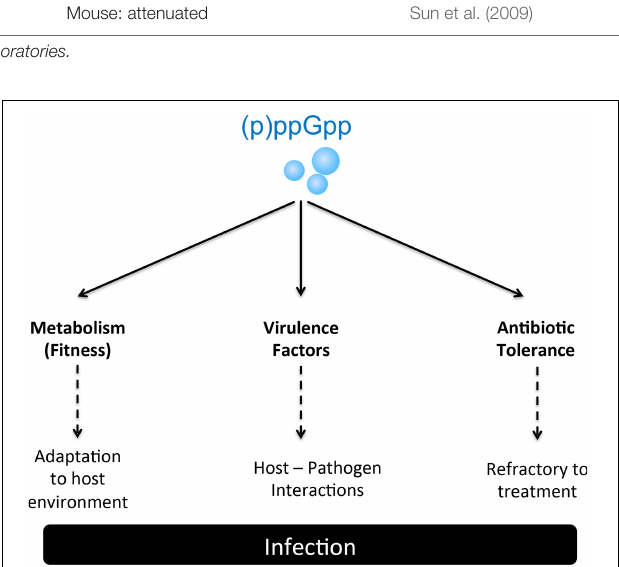
FIGURE 2 | (p)ppGpp participates in the regulation of several processes critical to bacterial pathogenesis. The roles of (p)ppGpp in adaptation to the host environment and antibioric tolerance are likely universal whereas the association with the expression of virulence factors appears to be